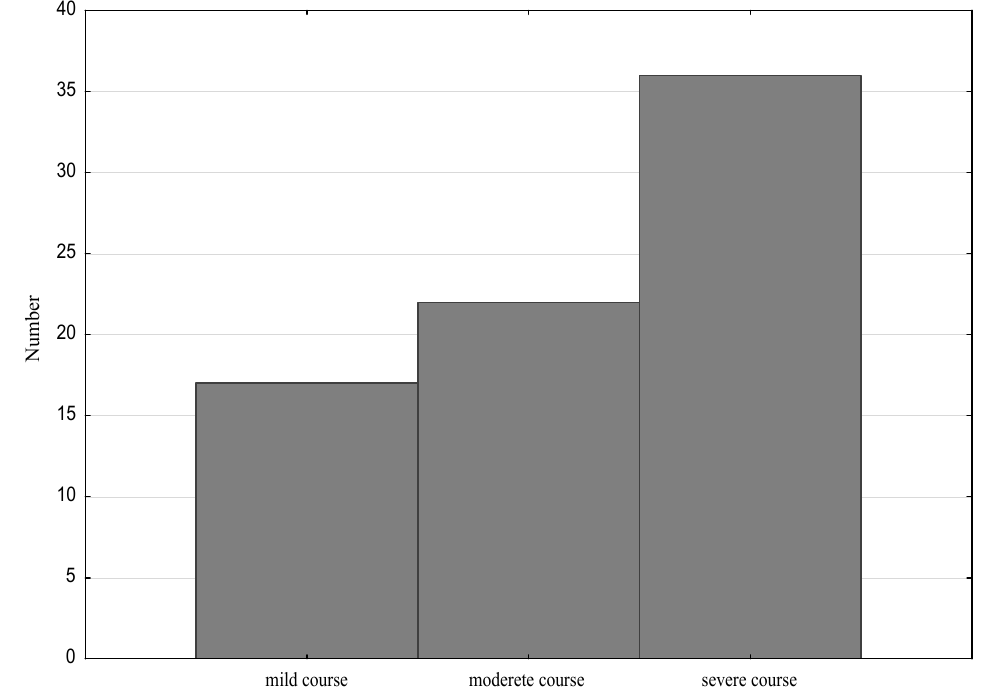
Figure 2. Number of vitamin D deficiency cases in the study group and the control.